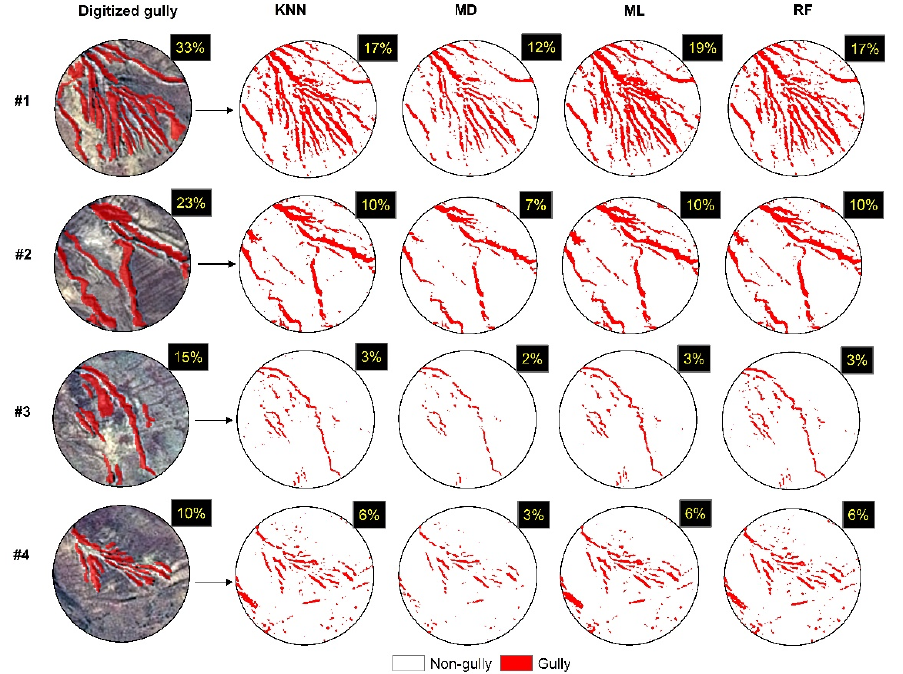
Figure 4. Selected gully sites (1–4) showing the spatial distribution of the classified gullies by different algorithms (KNN: k-nearest neighbor, MD: minimum distance, ML: maximum likelihood, RF: random forest) and actual (digitized) gullies.